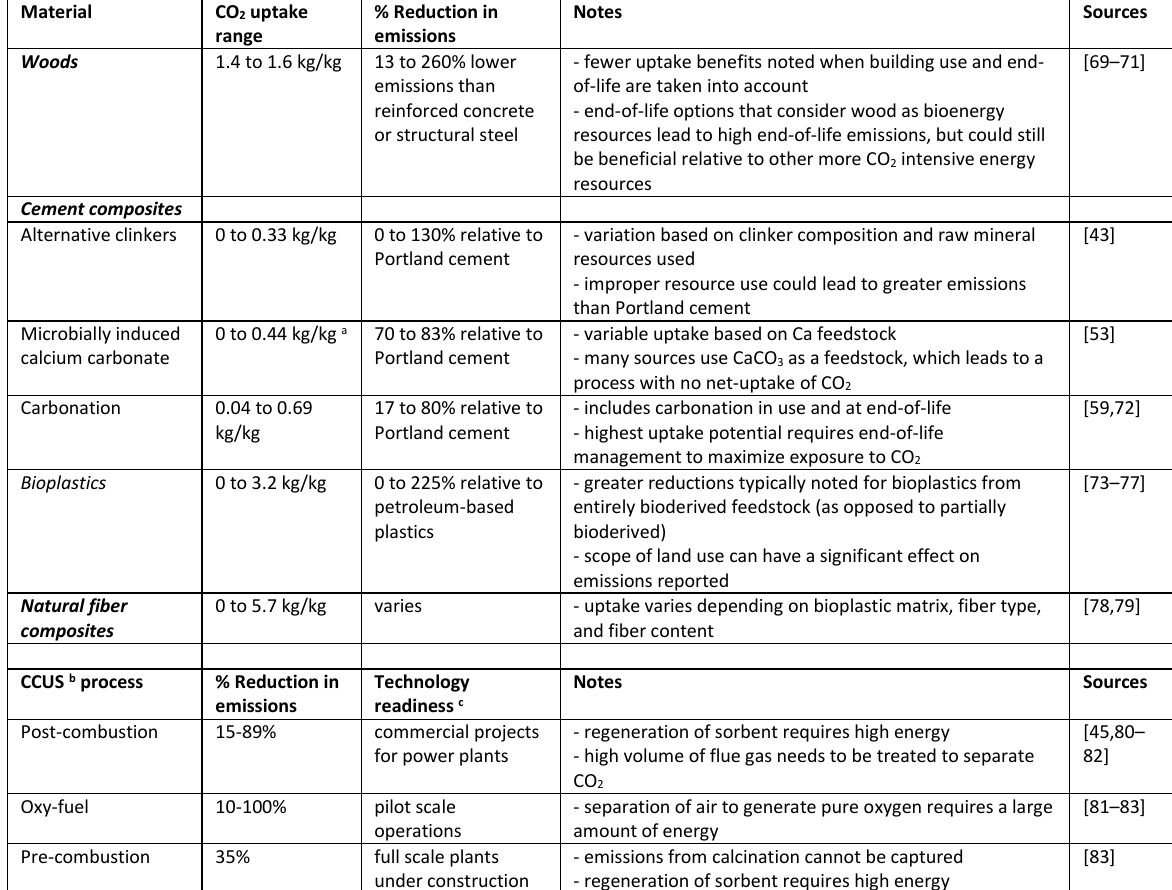
Table 2. CO 2 uptake ranges for example groups of materials (note: for CO 2 uptake, positive values indicate removal of CO 2 from the environment).